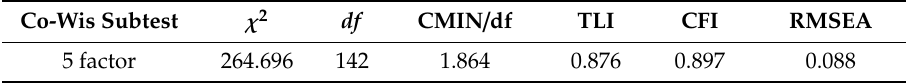
Table 7. Confirmatory factor analysis model validity of